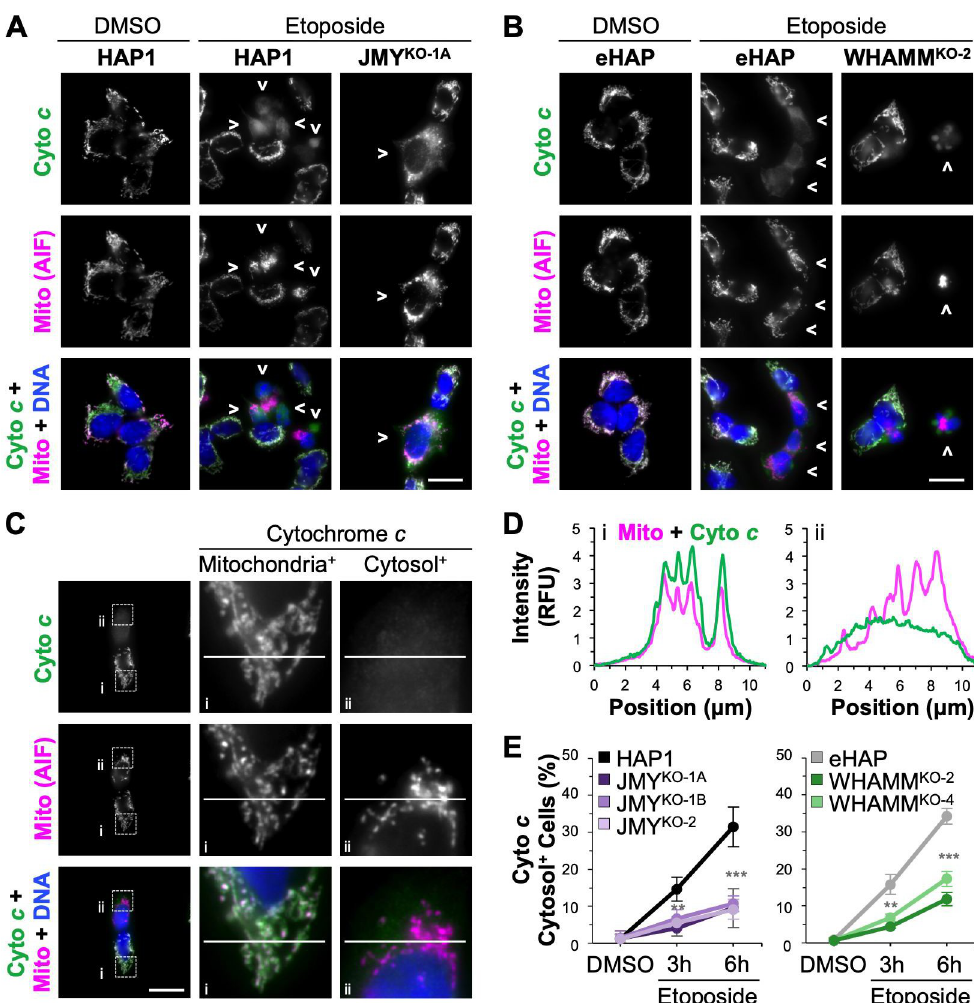
Fig 2. Cytochrome c release is delayed when JMY or WHAMM is deleted. (A-B) HAP1, JMY KO , eHAP, and WHAMM KO cells were treated with DMSO for 6h or 5 μ M etoposide for 3h or 6h before being fixed and stained with a cytochrome c antibody (Cyto c ; green), AIF antibody (Mito; magenta), and DAPI (DNA; blue). Images are from the 6h timepoint. Arrowheads highlight examples of cells with diffuse cytosolic cyto c staining. Scale bars, 25 μ m. (C) A representative image of HAP1 cells with magnifications depicts cyto c in the mitochondria (i) or diffuse in the cytosol (ii). (D) Lines were drawn through the magnified images using ImageJ to measure the pixel intensity profiles for cyto c and mitochondria, highlighting the differences in scoring mitochondrial versus cytosolic cyto c localization. (E) The % of cells with cytosolic cyto c staining was calculated in ImageJ by counting cells that exhibited cytosolic rather than mitochondrial cyto c staining and dividing by the total number of DAPI-stained nuclei. Each point represents the mean % ± SD from 3–4 experiments (n = 533–856 cells per point). Significance stars refer to comparisons of parental to KO samples at the depicted timepoints. �� p < 0.01; ��� p < 0.001 (ANOVA, Tukey post-hoc